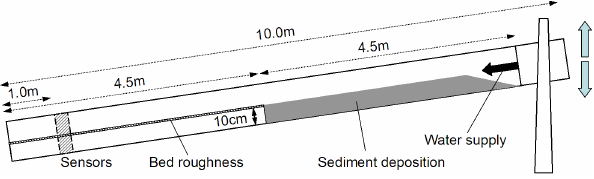
Fig. 1. Experimental setup.